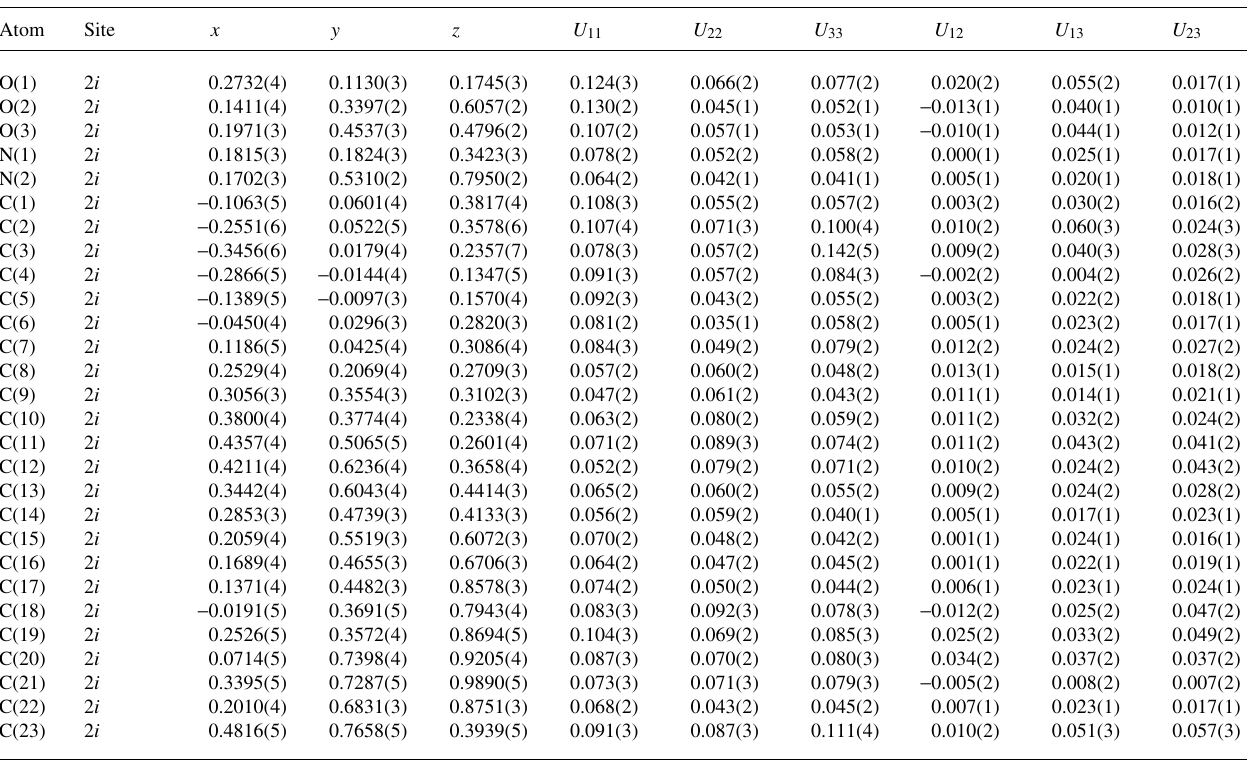
Table 3. Atomic coordinates and displacement parameters (in Å 2 )